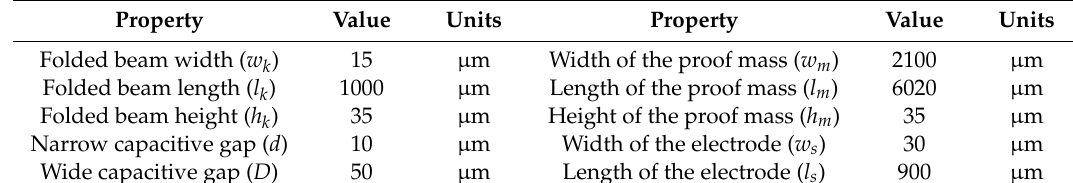
Table 2. The optimized design structure size.